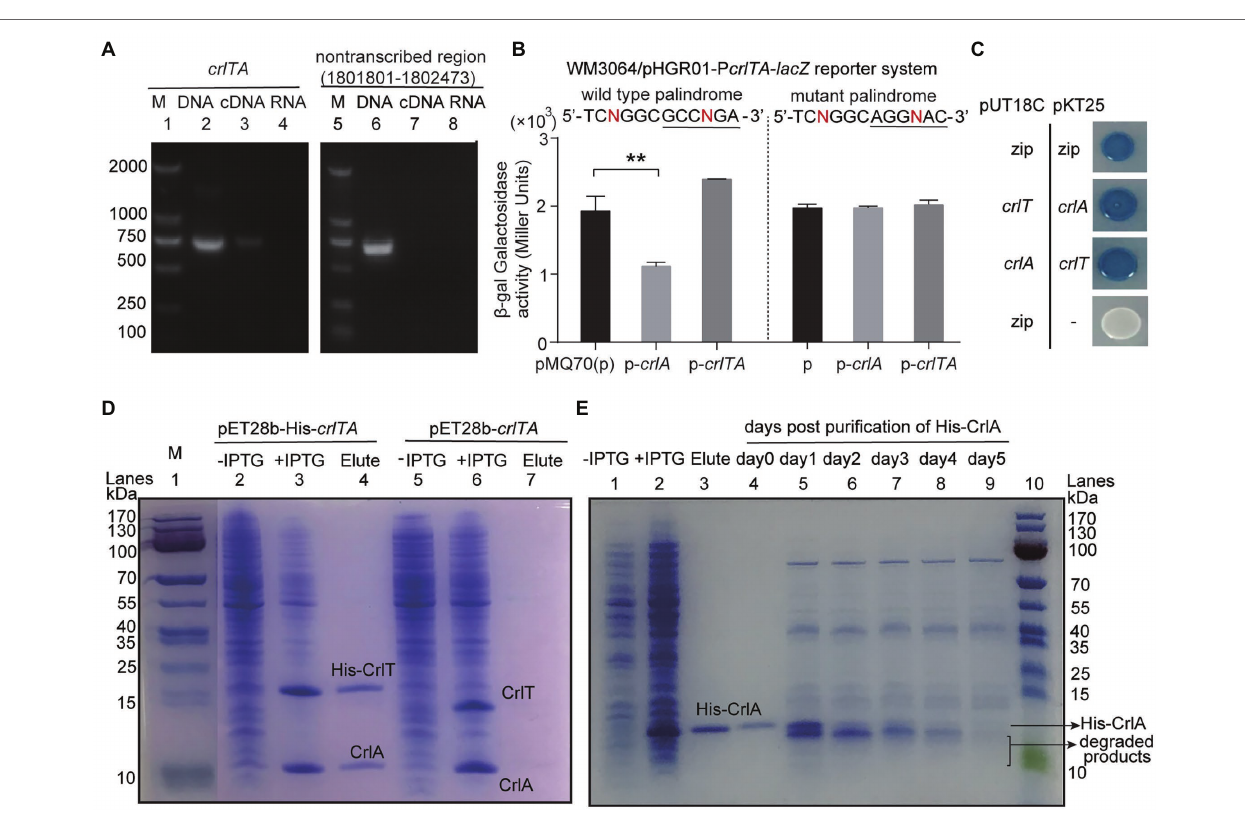
FIGURE 3 | Characteristics of the type II TA pair CrlTA. (A) Total gDNA and RNA were extracted from P. aeruginosa WK172, and total RNA was used to synthesize cDNA. PCR was carried out by primer pairs crlT -F/ crlA -R and non-transcribed region-F/R using gDNA (lanes 2, 5), cDNA (lanes 3, 6), and RNA (lanes 4, 7). The DNA marker (M) is in lane 1. (B) Mid-log phase WM3064 cells carrying reporter plasmids pHGR01-P crlTA-lacZ or pHGR01-MP crlTA-lacZ (M indicates mutant) were transfected with pMQ70-based plasmids. The double plasmid systems were used to test β -galactosidase activity with induction of 10 mM arabinose for 3 h. Student’s t -test was used for statistical analysis and error bars indicate the standard error of the mean ( n = 3, p < 0.01 is shown in **). (C) CrlT and CrlA were fused to the T18 catalytic domain in pUT18C and the T25 catalytic domain in pKT25, respectively. In contrast, CrlT and CrlA were also fused to T25 and T18 in the corresponding pKT25 and pUT18C. Cells harboring pKT25- zip and pUT18C- zip plasmids were used as positive controls, and cells harboring pKT25 (without an insert) and pUT18C- zip plasmids were used as negative controls. (D) NHis-tagged CrlT and untagged CrlA were produced from pET28b-His- crlTA in E. coli BL21. CrlA (11.92 kDa) was copurified with NHis-CrlT (14.73 kDa, lane 4). Cells harboring pET28b- crlTA were used as a negative control (lane 7). The protein marker (M) was loaded in lane 1. (E) NHis-tagged CrlA was purified and stored at 4 ° C, and the stability of the purified protein was determined each day after purification.